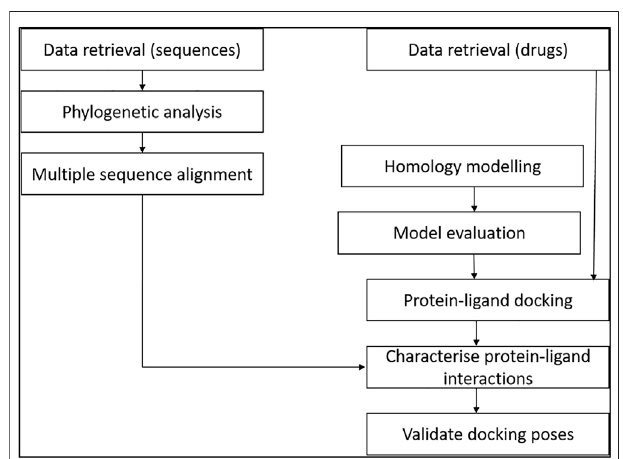
FIGURE 1 | Study design of the methodology. The relationship of data from multiple sequence alignment of related species to human STEAP2 gave insight on key protein residues important in function of the protein to look out for in ligand interaction with the protein during protein – ligand